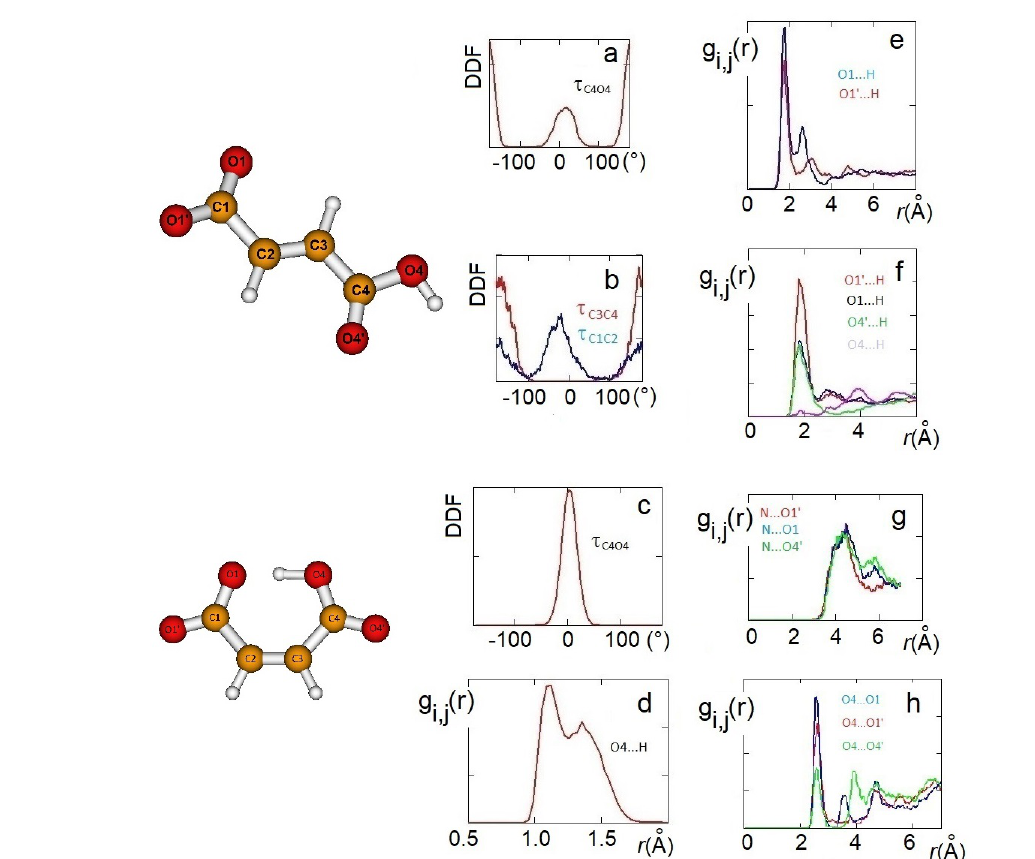
Figure 4. AIMD results: HO4C4C3 dihedral angle distribution functions (DDFs) of [Ch][H-fumarate] ( a ) and [Ch][H-maleate] ( c ); O4C4C3C2 and O1C1C2C3 DDFs of [Ch][H-fumarate] ( b